Question: What form of chart is displayed?
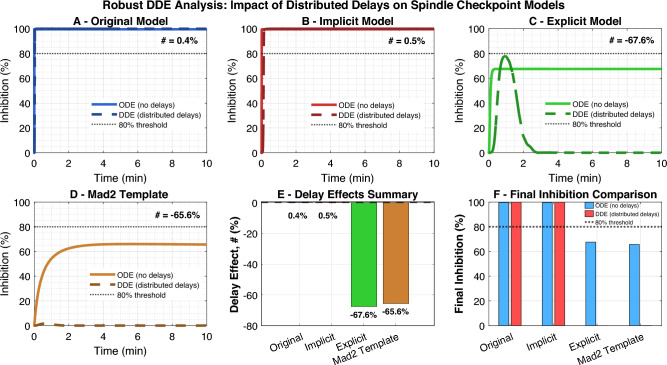
Answer: line